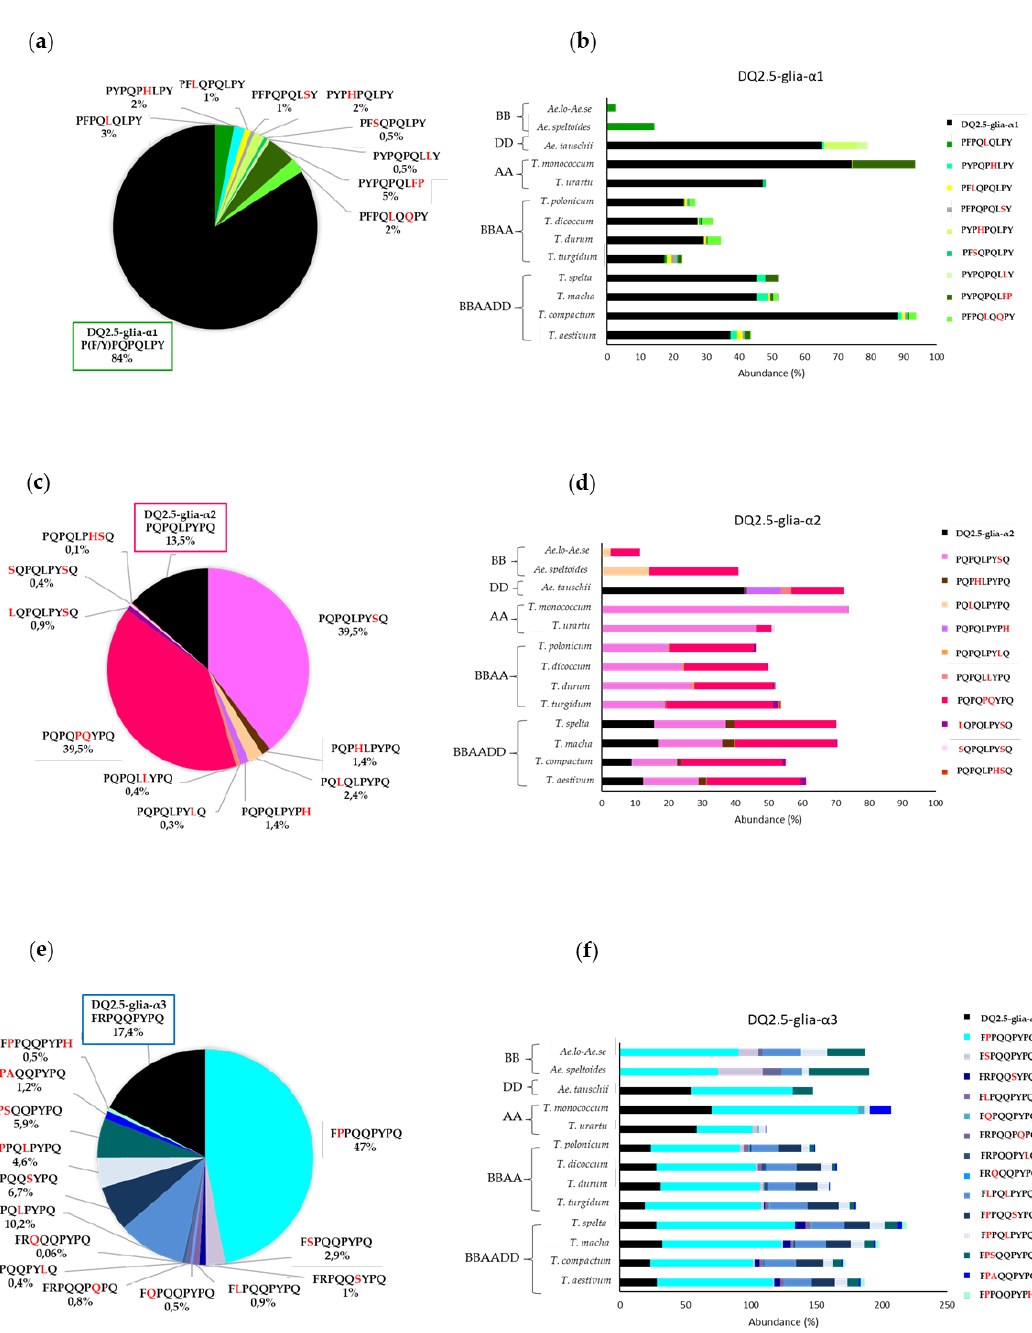
Figure 4. Abundance of CD canonical epitopes and variants per wheat species. ( a ) Abundance in the DQ2.5-glia- α 1 epitope variants, ( b ) abundance in DQ2.5-glia- α 1 epitope variants by species, ( c ) abundance in DQ2.5-glia- α 2 epitope variants, ( d ) abundance in DQ2.5-glia- α 2 epitope variants by species, ( e ) abundance in DQ2.5-glia- α 3 epitope variants, and ( f ) abundance in DQ2.5-glia- α 2 epitope variants by species.